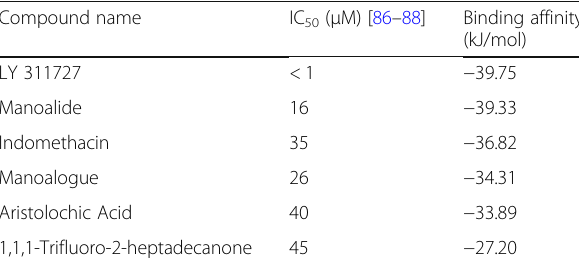
Table 11 Binding affinities (kJ/mol) and in vitro inhibitory activity (IC 50 ) of different PLA2